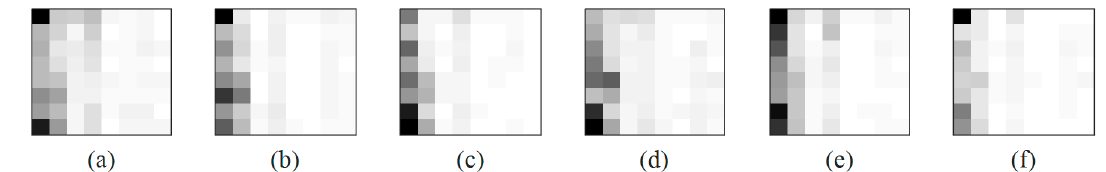
Table 3. The diagnosis accuracy of the proposed models (%).